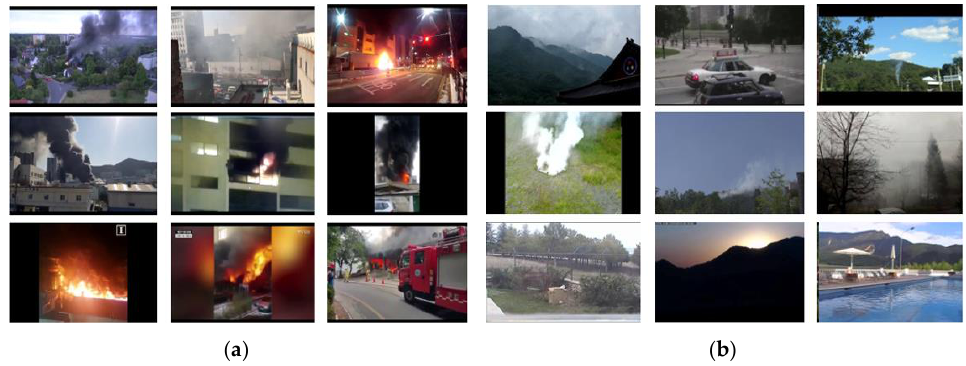
Figure 10. Sample still shots including flame, smoke, and non-fire objects taken from video clips for LSTM training. The ( a ) images are taken from videos of fire, while the ( b ) images are from non-fire video